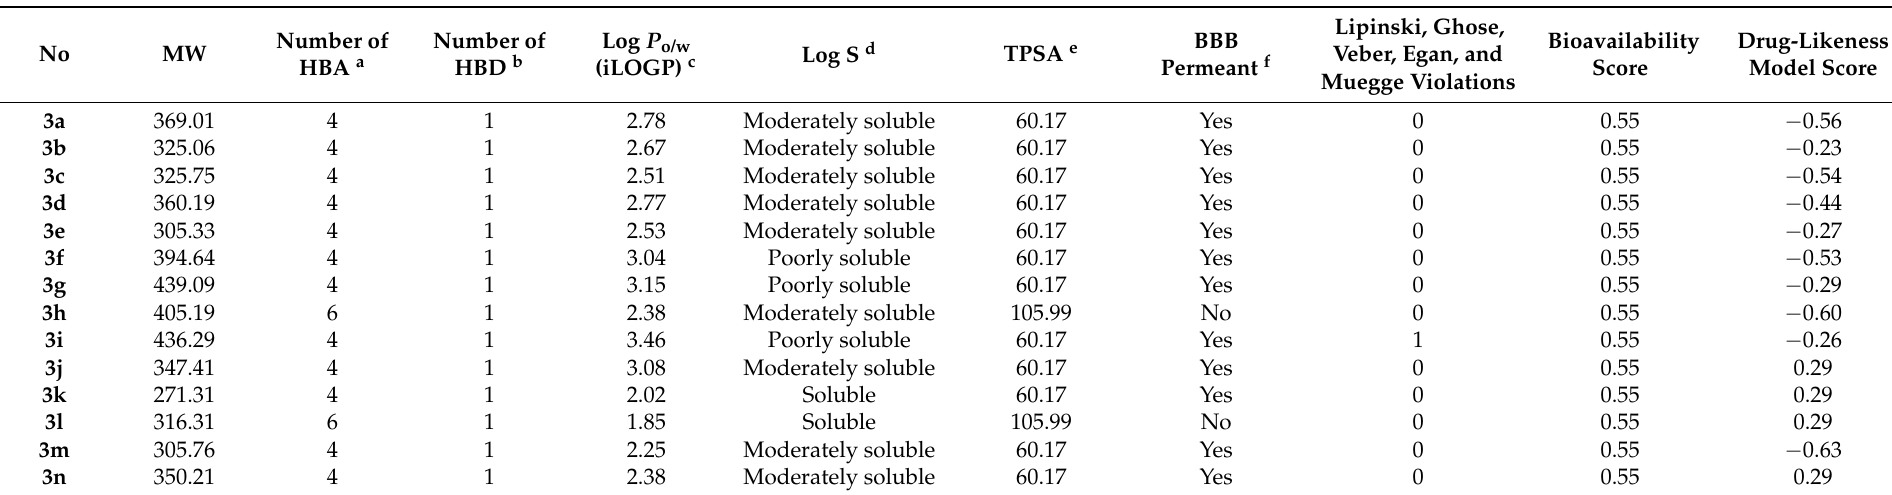
Table 4. Drug-likeness predictions and physicochemical/pharmacokinetic/ADME properties of tested